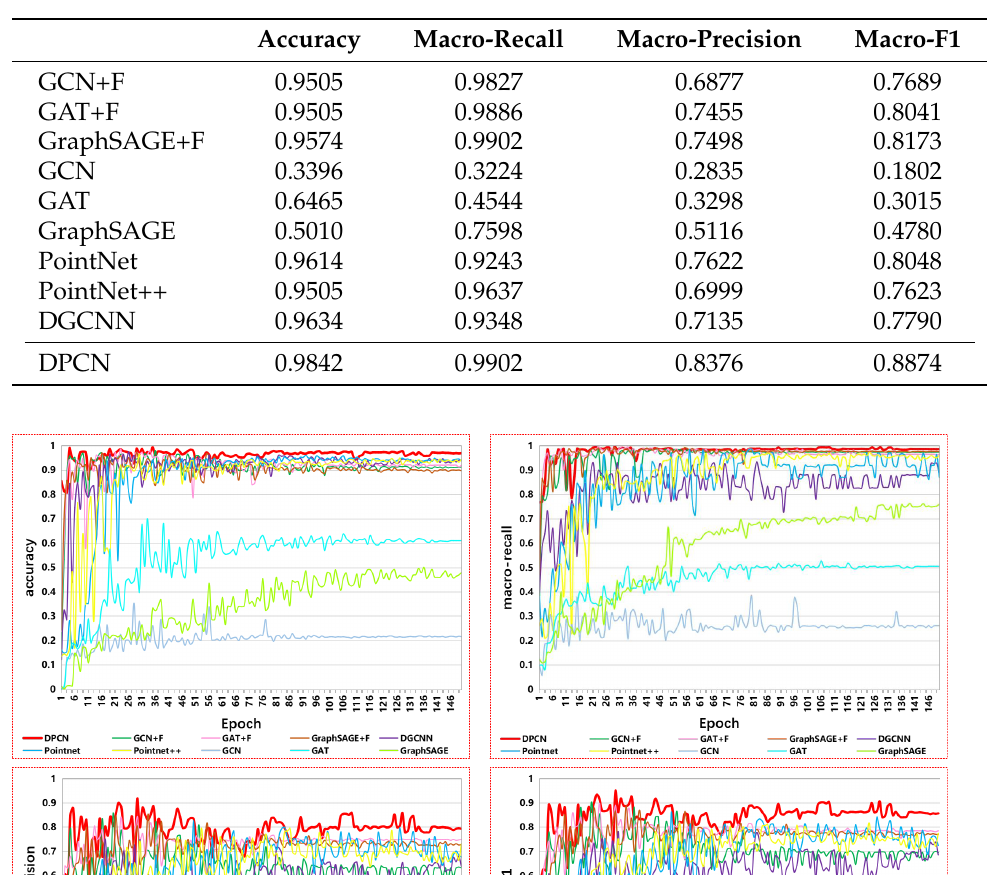
Table 3. The results of graph neural network methods(two cases), point cloud neural network methods, and our proposed DPCN using the same experimental environment and parameters.